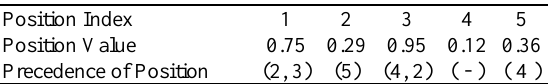
Table 2. Example of the modified smallest position value rule.